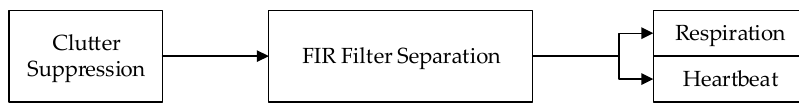
Figure 3. Traditional FIR filtering method.